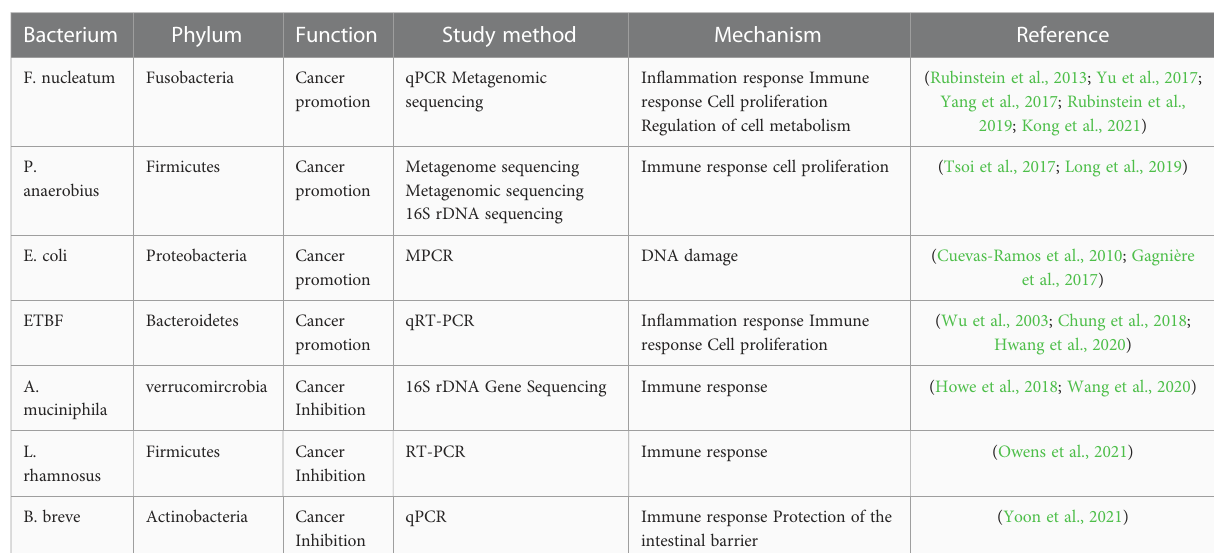
TABLE 3 The intestinal bacteria associated with